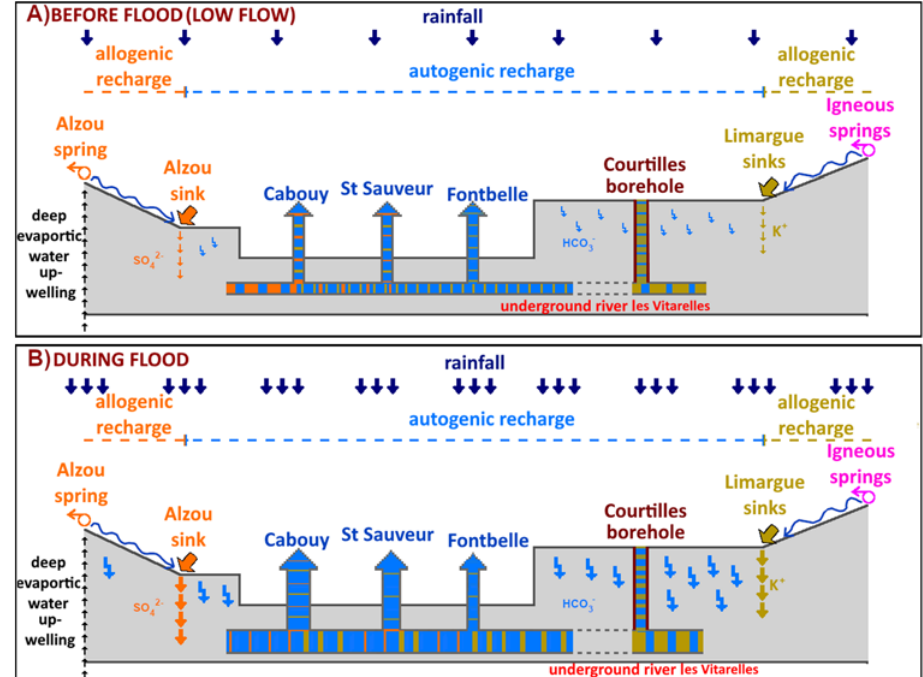
Figure 6. Conceptual model synthesizing the results of the mixing model.